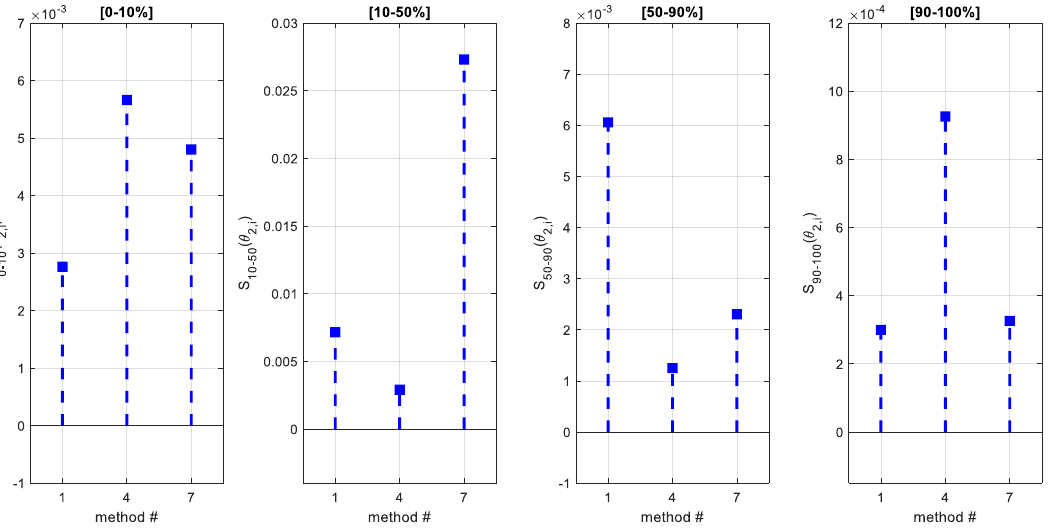
Figure 20. Graphical representation of data given in Table 20 for process P 2 . From left to right the performance indexes S 0‒10 ( θ ̅ 2,i ), S 10‒50 ( θ ̅ 2,i ), S 50‒90 ( θ ̅ 2,i ), and S 90‒100 ( θ ̅ 2,i ), are shown for methods #1, #4, and #7, respectively.